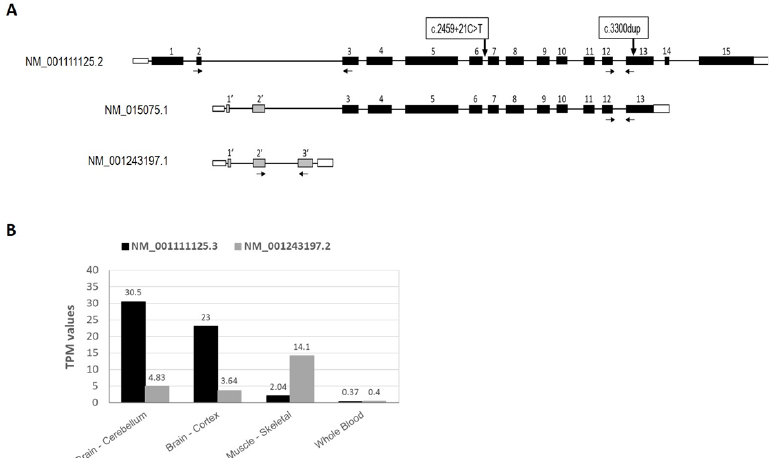
Figure 1. ( A ) Representation of IQSEC2 isoforms. Schematic representation of large isoform (NM_001111125) which include 15 exons; intermediate isoform (NM_015075) which include 14 ex- ons; and short isoform (NM_001243197) which include 3 alternative exons. Primers used for the quantitative expression of the long and short isoforms are represented by arrows. ( B ) Isoforms ex- pression of IQSEC2 in different tissues obtained from GTEX database (https://www.gtexportal.org, accessed on 30 May 2022). TPM values corresponding to the larger IQSEC2 isoform (NM_001111125) and the short isoform (NM_001243197) are represented as the expression values in brain cerebellum and cortex, skeletal muscle and whole blood. IQSEC2 encodes the IQSEC2 protein, also known as BRAG1 (brefeldin A resistant Arf-guanine nucleotide exchange factor 1), a guanine nucleotide exchange factor (GEF) present in the postsynaptic density of synapses (PSD) in the forebrain. The principal sub- strate of IQSEC2 is the ADP-ribosylating factor 6 (ARF6) which regulates actin dynamics and membrane trafficking in neurons. [10]. BRAG1 is one of the most abundant proteins